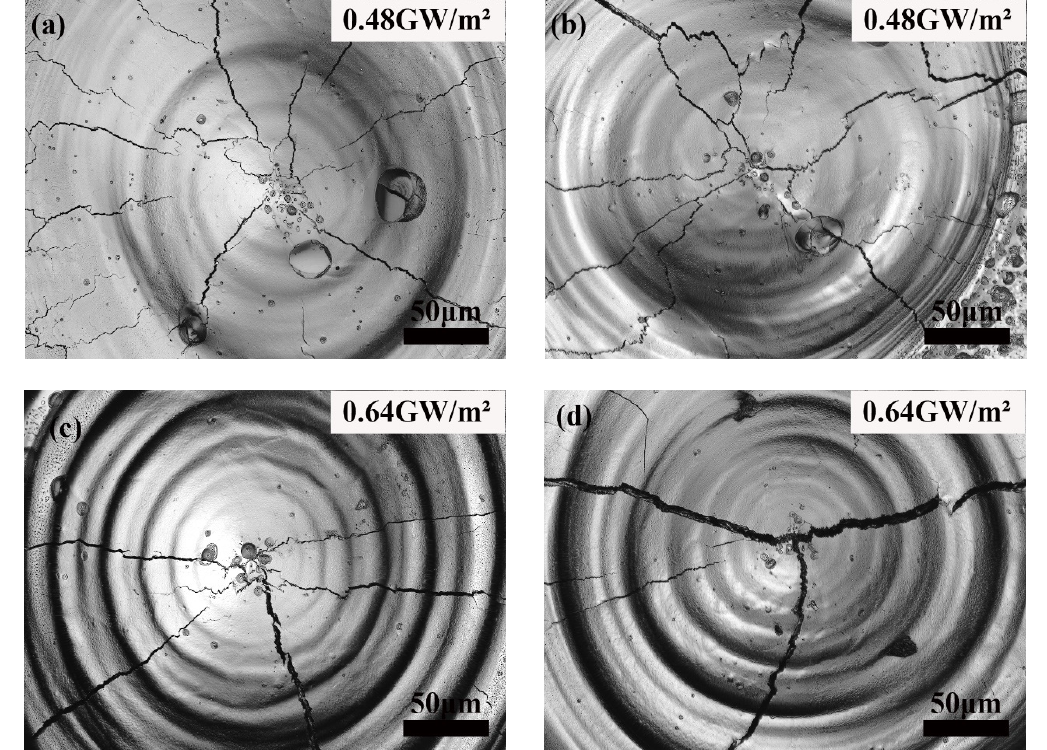
Figure 11. The local surface morphologies from Figure 6c,d,g,h: rolled sample ( a , c ) and fully recrys- tallized sample ( b , d ).